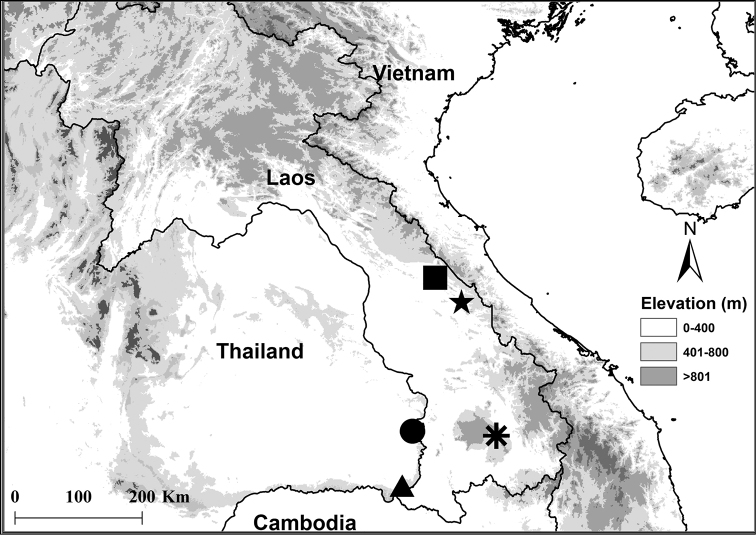
Localities of studied specimens of Limnonectessavan sp. nov. at the holotype locality at Savannakhet Province, Vilabouli District, Laos (star) and the paratype localities at Khammouan Province, Boualapha District, Laos (square), Champasak Province, Pakxong District, Laos (asterisk), Ubon Ratchathani Province, Sirindhorn District, Thailand (circle), and Ubon Ratchathani Province, Na Chaluai and Buntharik Districts, Thailand (triangle).